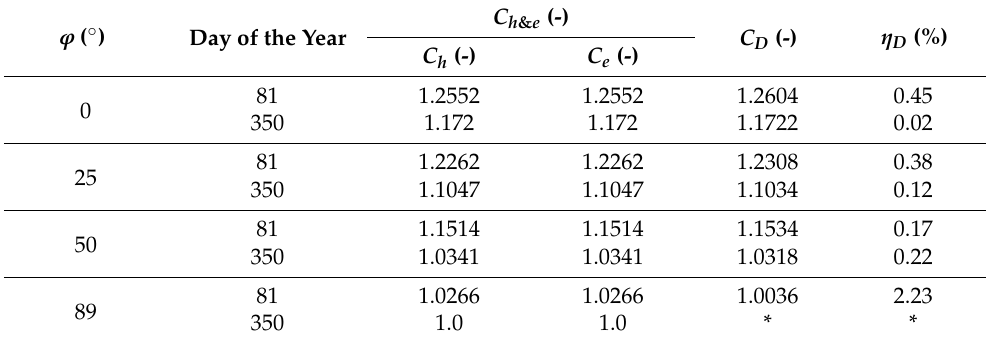
Table 1. Comparisons of C h , C e , C h & e , C D , η D while β = 0.